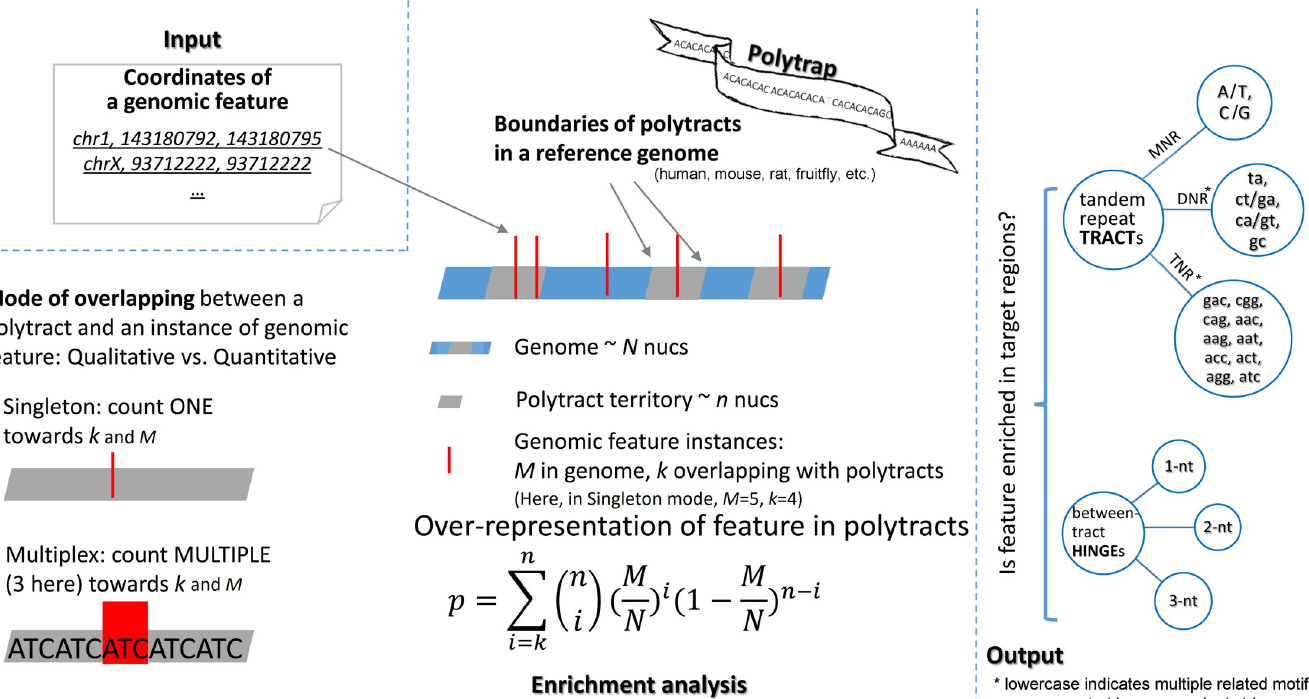
Fig 6. Schema of software package Polytrap. Polytrap stores chromosome locations of polytracts (1-mer, 2-mer, and 3-mer tandem repeats, termed MNR, DNR, and TNR) in a reference genome, and calculates the probability of enrichment of user-given genomic feature within polytracts. For a genome of totally N nucleotides and a polytract territory of n nucleotides, the probability of k out of M instances of a genomic feature being located within tracts is calculated through the binomial model. When the overlapping mode is switched from “singleton” to “multiplex,” k and M designate number of aggregate nucleotides instead of instances (bottom left part).